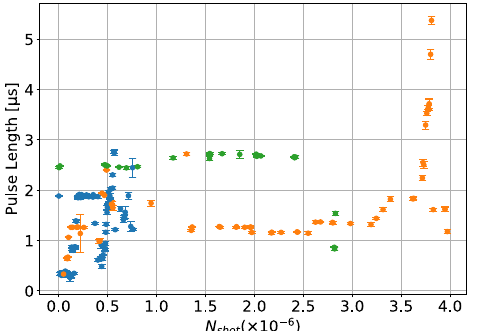
FIG. 7. The history of the rf-frequencydifference from the initial rf-frequency, δ f , during the high power test for three cavities, rf DAA2-1-uncoated (green), DAA2-2-DLC (blue), and DAA2-3- DLC(orange). Thehorizontalaxesdenotethenumber ofshotsofrf pulse injected to each cavity with a repetition rate of 50